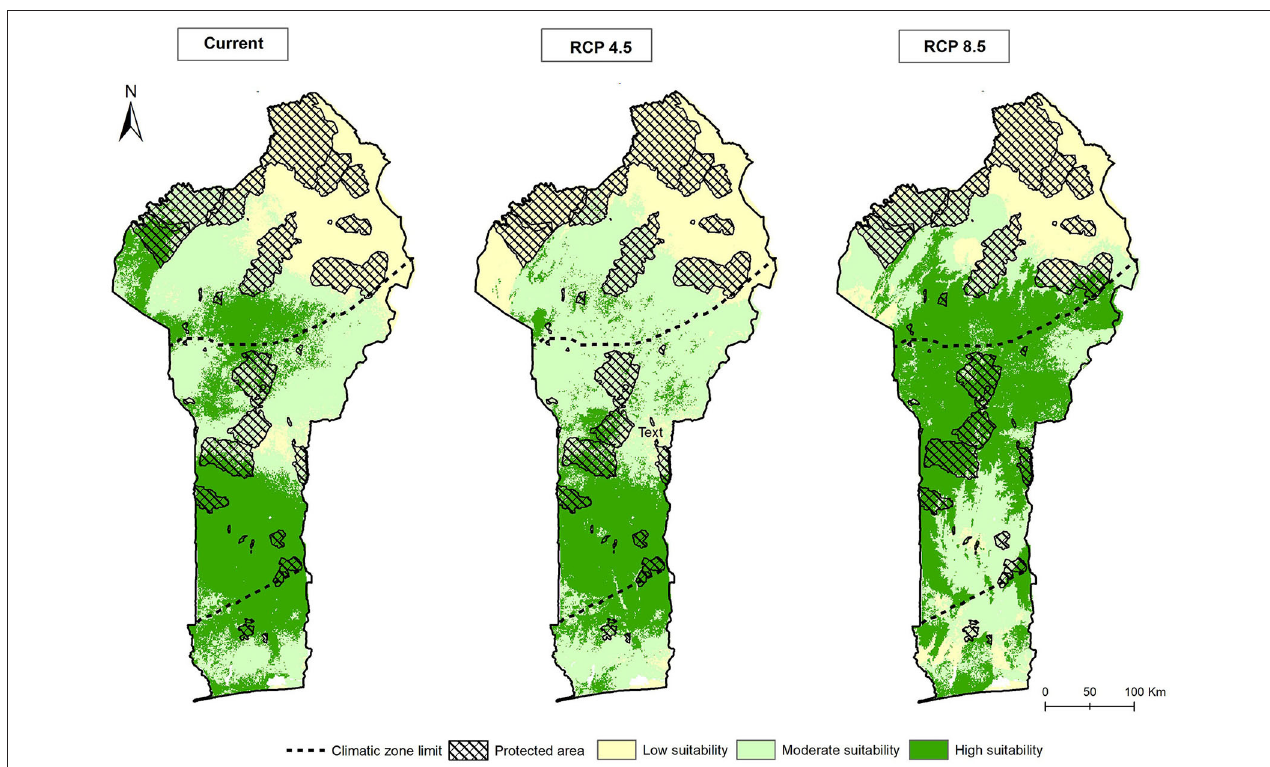
FIGURE 5 | Predicted hotspot distribution maps of potentially suitable habitats of the 15 Vigna CWR taxa in Benin under the current and future climates.